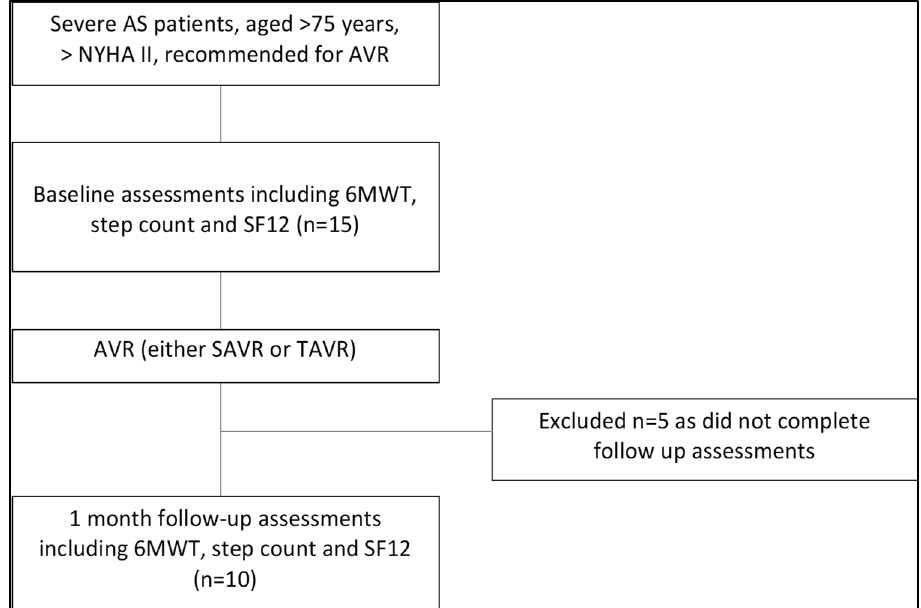
Figure 1. PRISMA diagram.